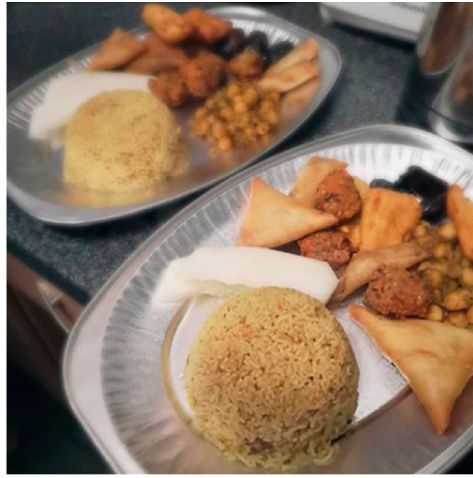
Figure 8. Food platter given out to neighbours (Zahra, Diary Image, Entry 1).